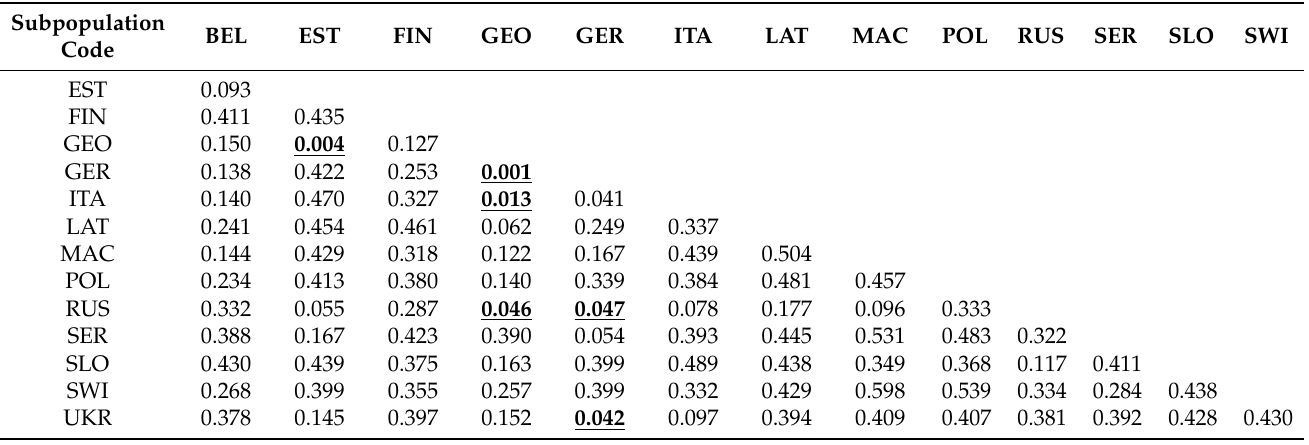
Table 4. Significance of differences in allelic patterns between the investigated subpopulations. AMOVA results are given as p -values, with statistically significant p -values given in bold and underlined.